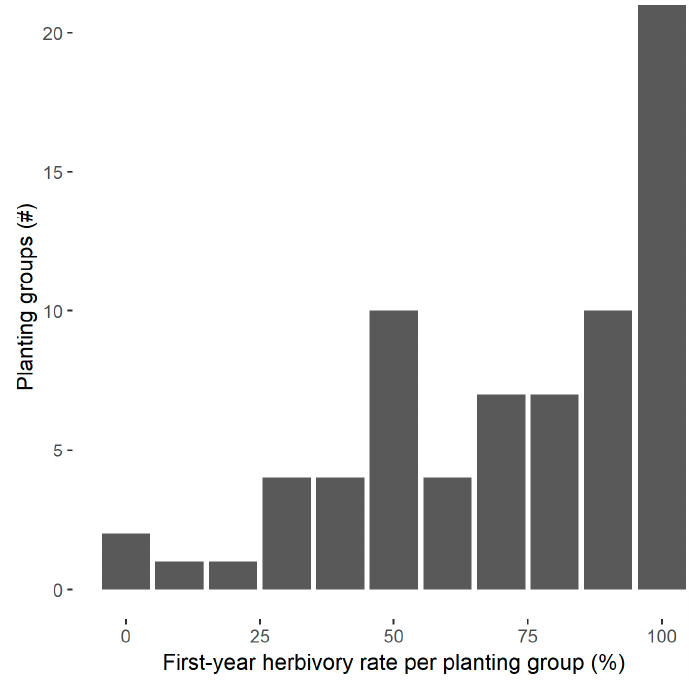
Figure 4. Frequency of first-year herbivory rates for individual planting groups ponderosa pine seedlings in the Davis Mountains. Herbivory rate per planting group refers to the proportion browsed (dead) seedlings within a planting group.